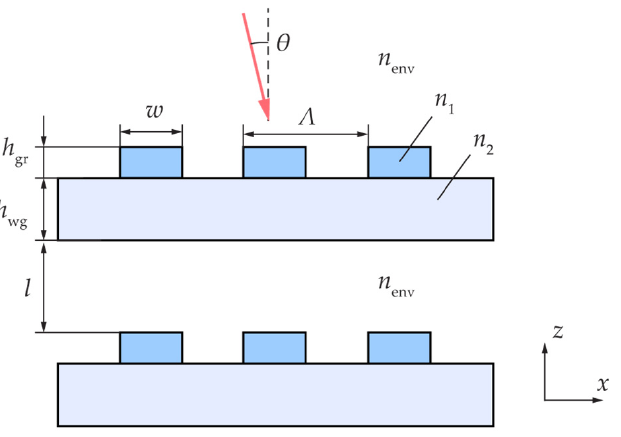
Figure 1. Geometry of a stacked structure containing two identical resonant gratings.